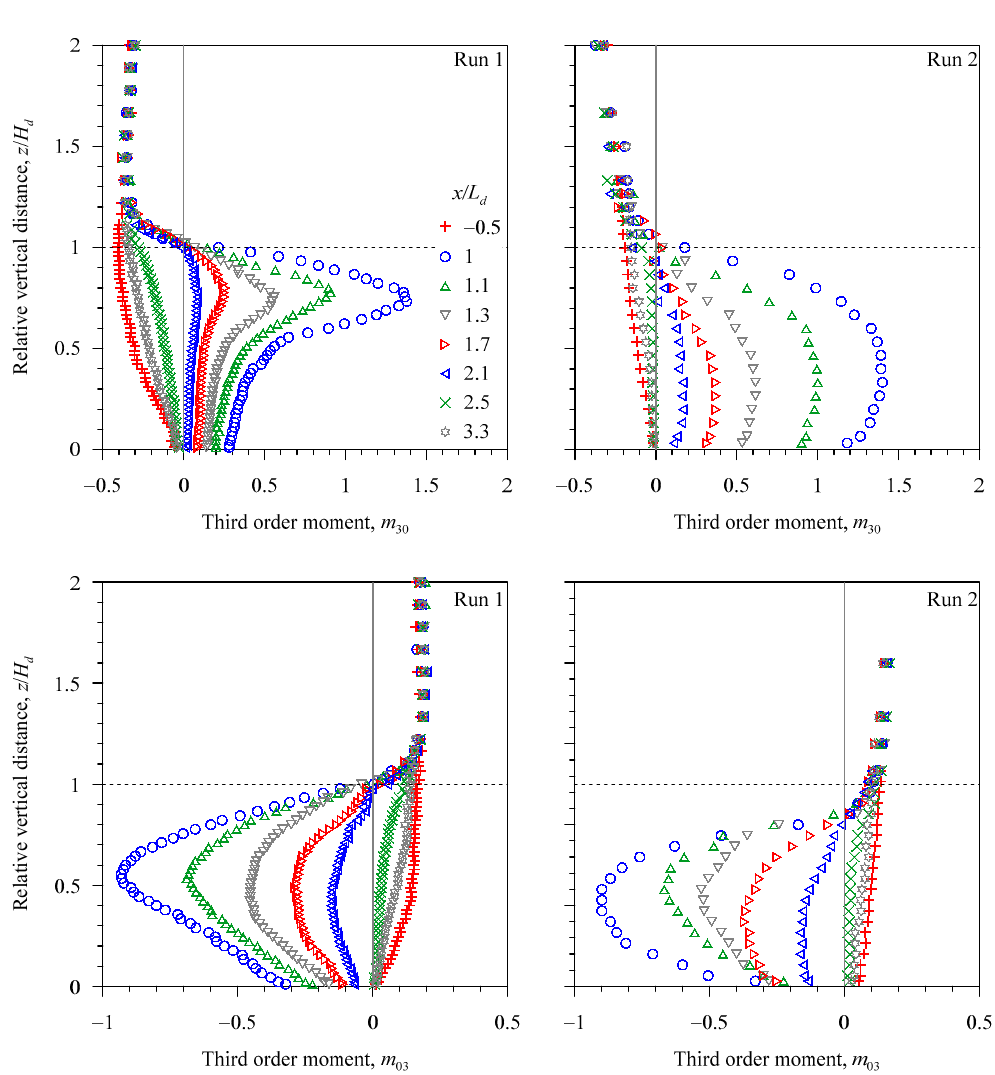
Figure 7. Vertical profiles of third-order moments m 30 and m 03 at various relative streamwise distances x / L d in Runs 1 and 2.